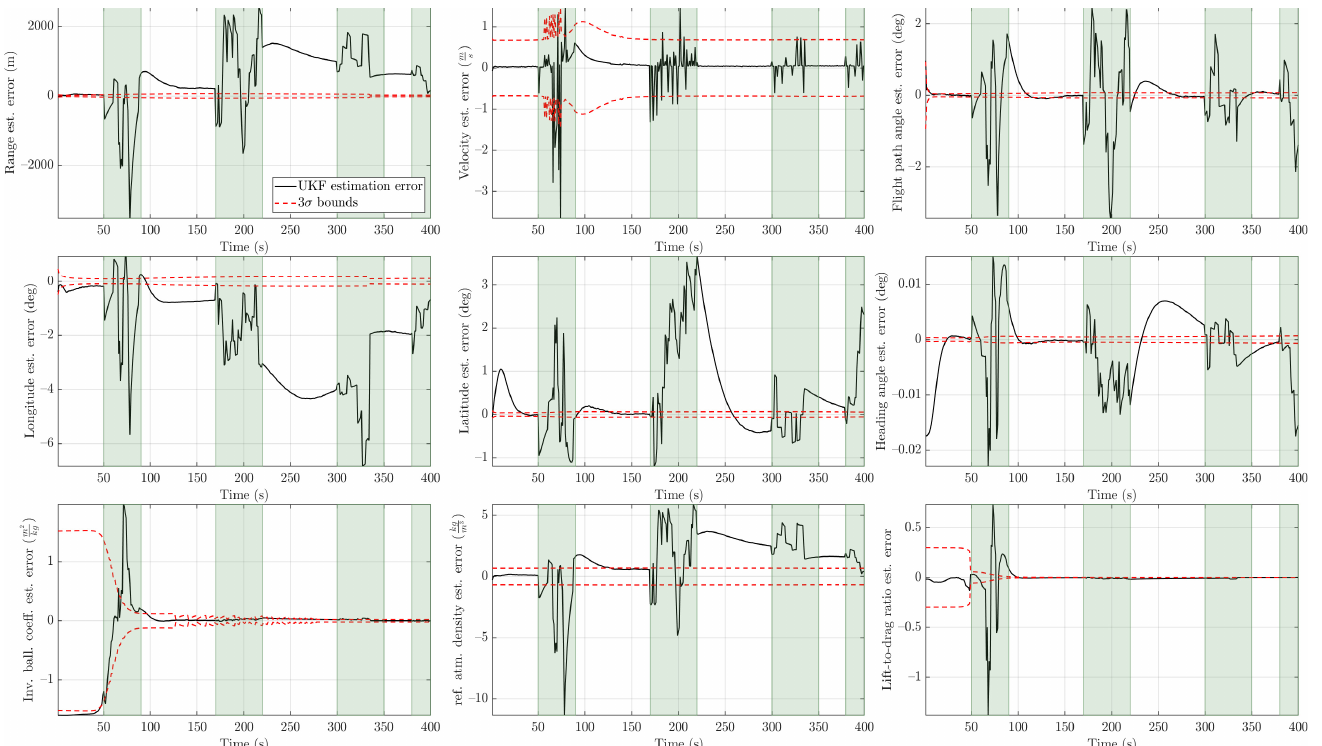
Figure 16. UKF estimation errors with 3 σ bounds for (cid:101) = 0.4 (the time intervals shaded in light green are intervals in which outliers are present).